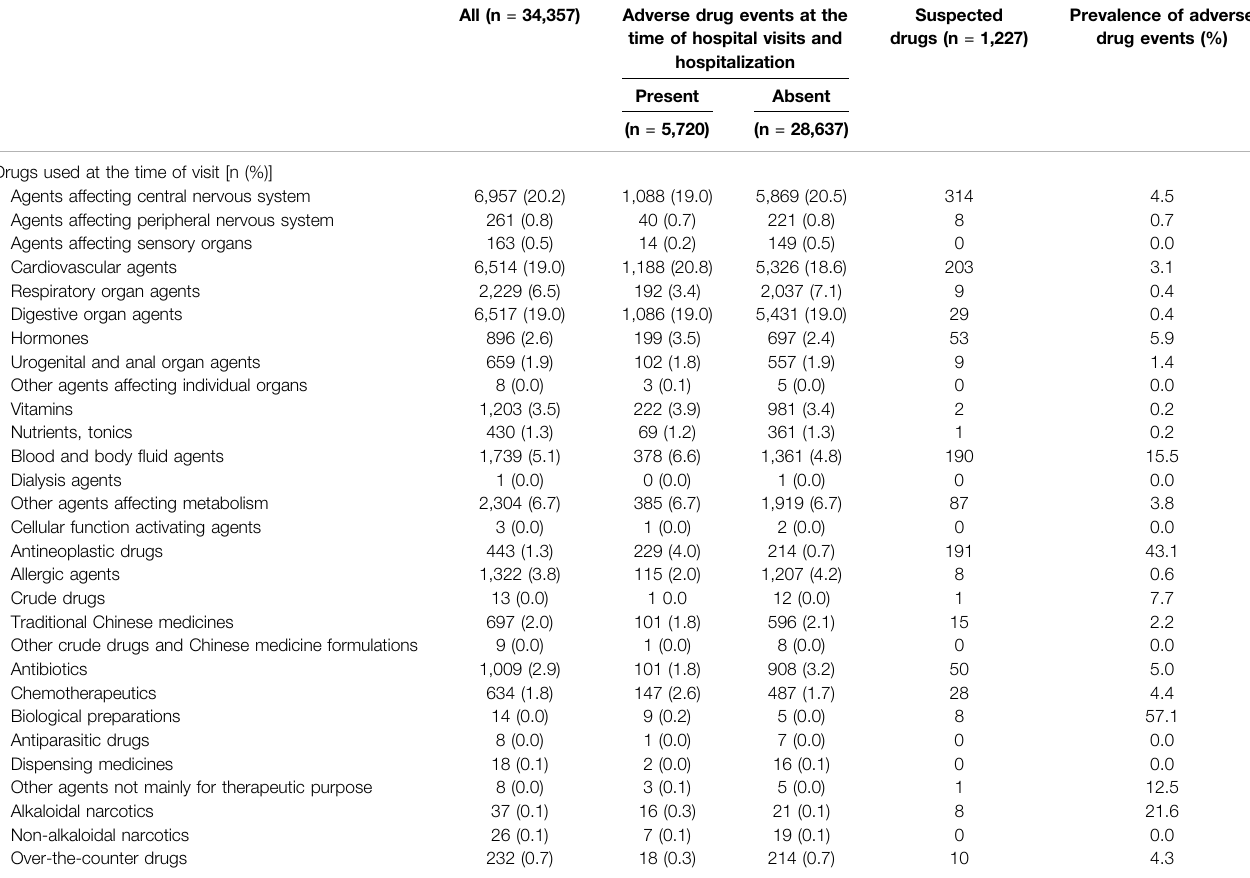
TABLE 3 | Drug categories.